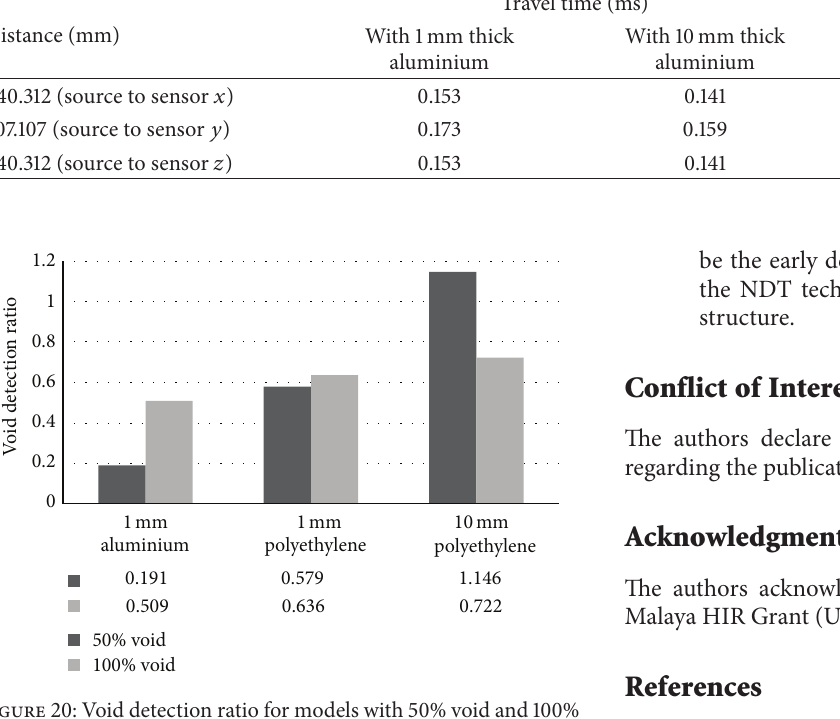
Figure 20: Void detection ratio for models with 50% void and 100% void.